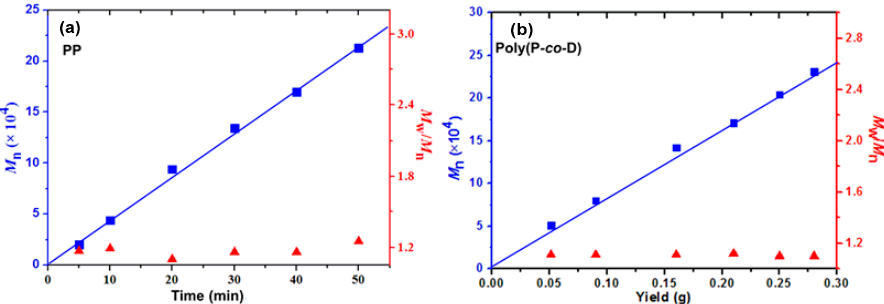
Figure 2. Plots of M n ( ■ ) and M w / M n ( ▲ ) versus polymerization time for propylene polymerization (( a ), 5–50 min, Table 1) and copolymer yield for P / 1-decene copolymerization (( b ), Table 3) catalyzed by 2 -MMAO at 25 °C. Table 2. Microstructure analyses of the polypropylenes obtained by complexes 2 and 5 (Table 1).